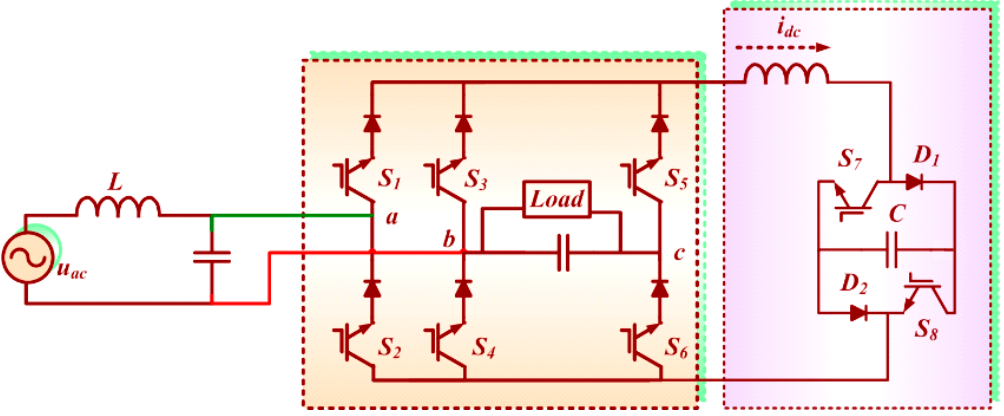
Figure 5. Power decoupling solution in [32].